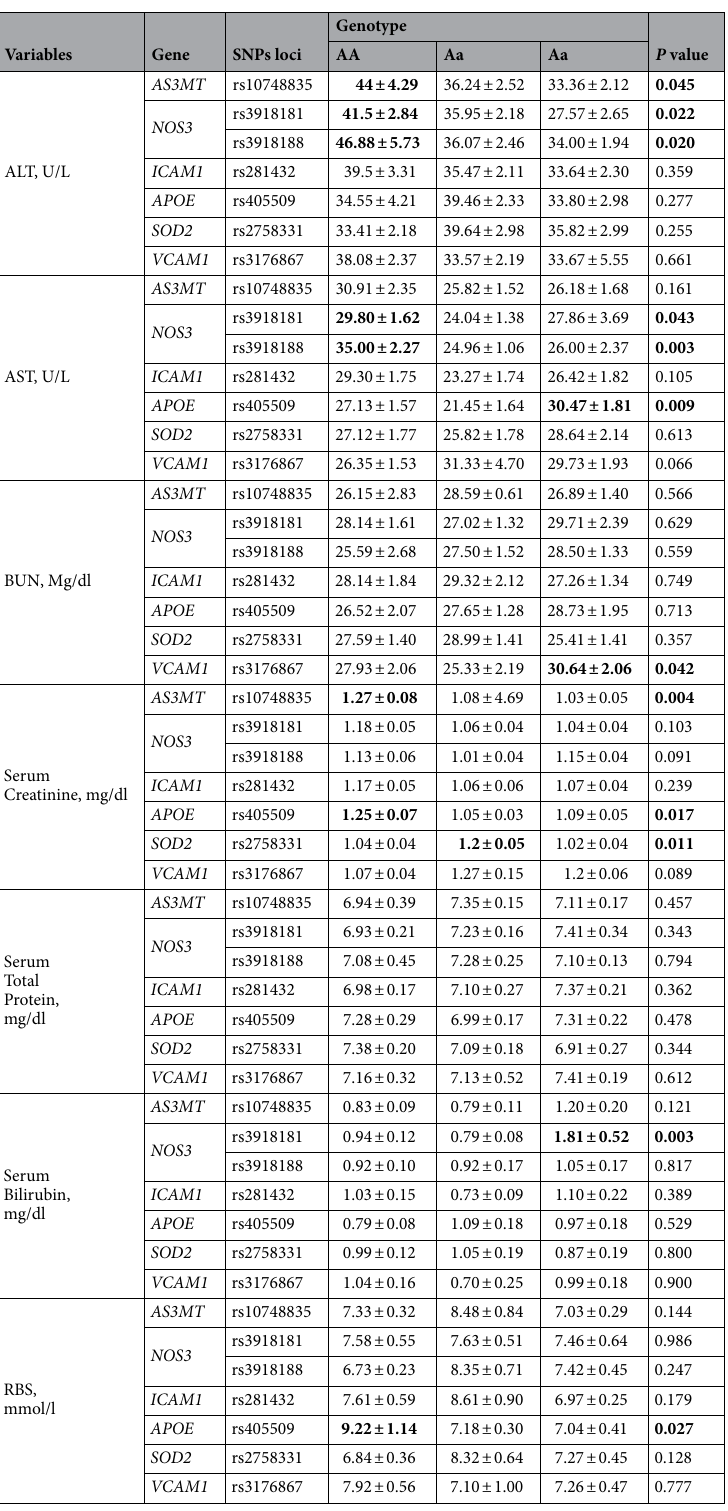
Table 6. Relationship between genetic polymorphisms and biochemical parameters. AS3MT rs10748835 A/G, NOS3 rs3918181 A/G, NOS3 rs3918188 A/C, ICAM1 rs281432 C/G, VCAM1 rs3176867 A/C/T (the data for AA genotype was excluded here), SOD2 rs2758331 A/C and APOE rs405509 G/T. ALT = serum alanine amino- transferase, AST = serum aspartate amino-transferase, BUN = blood urea nitrogen. The data were analyzed by ANOVA. Significant values ( P < 0.05) are typed in bold